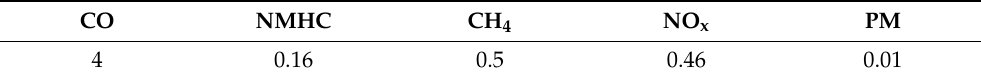
Table 2. EU VI emission standards for heavy-duty and transit testing in g/kWh.